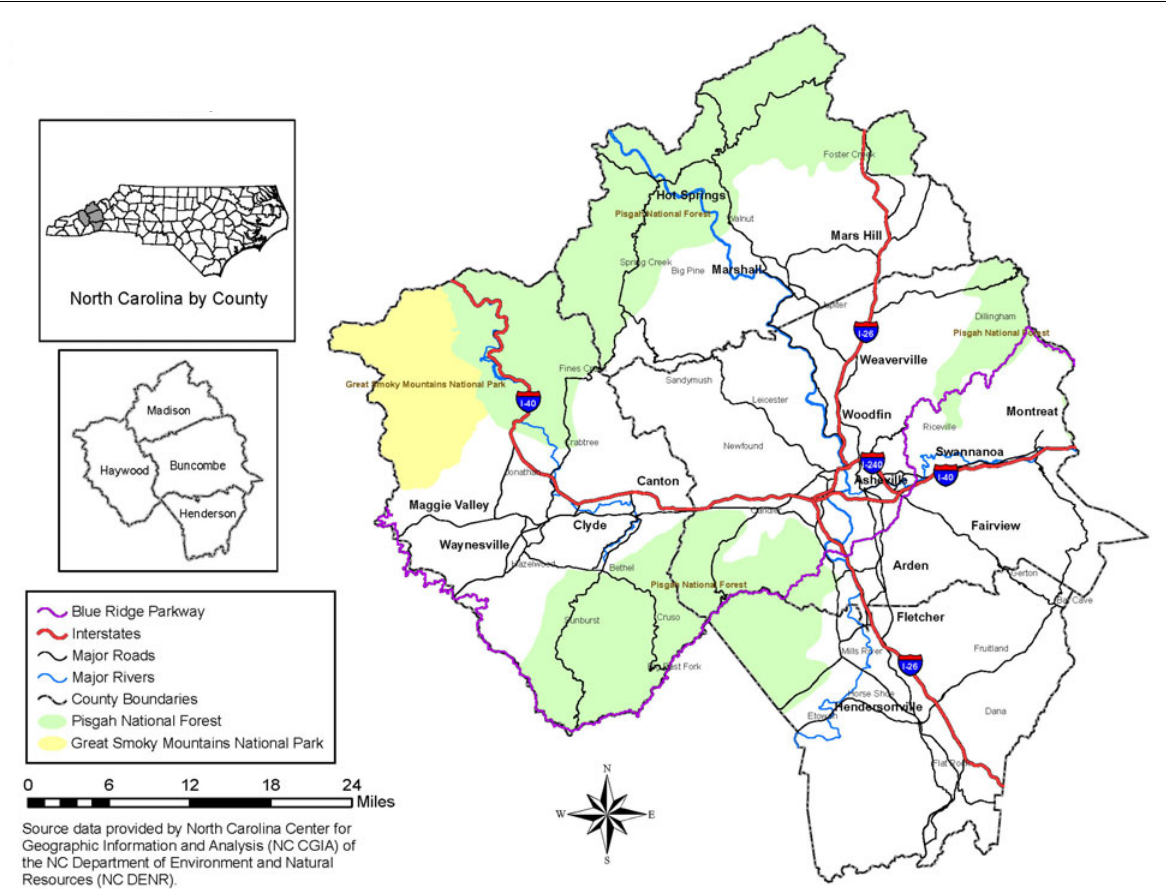
Figure 1. Farmland Values Project: The Four-County Study